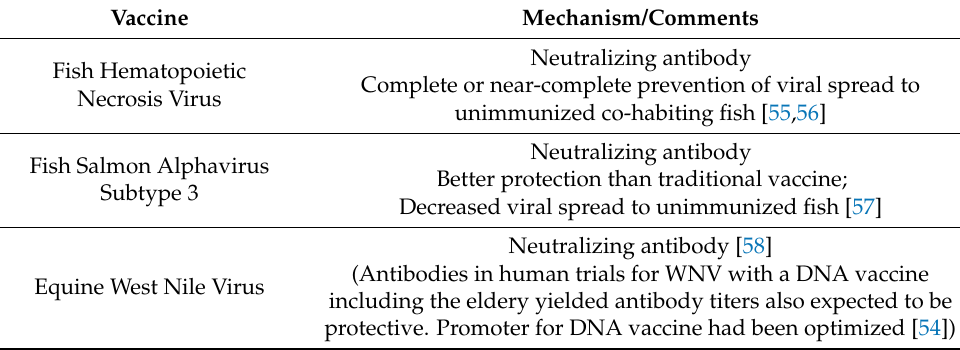
Table 5. Immune Mechanisms of Licensed Veterinary DNA